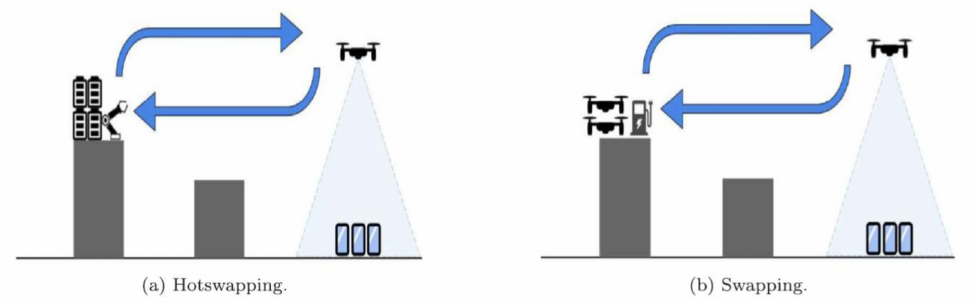
Figure 4. Swapping vs. hot swapping technique